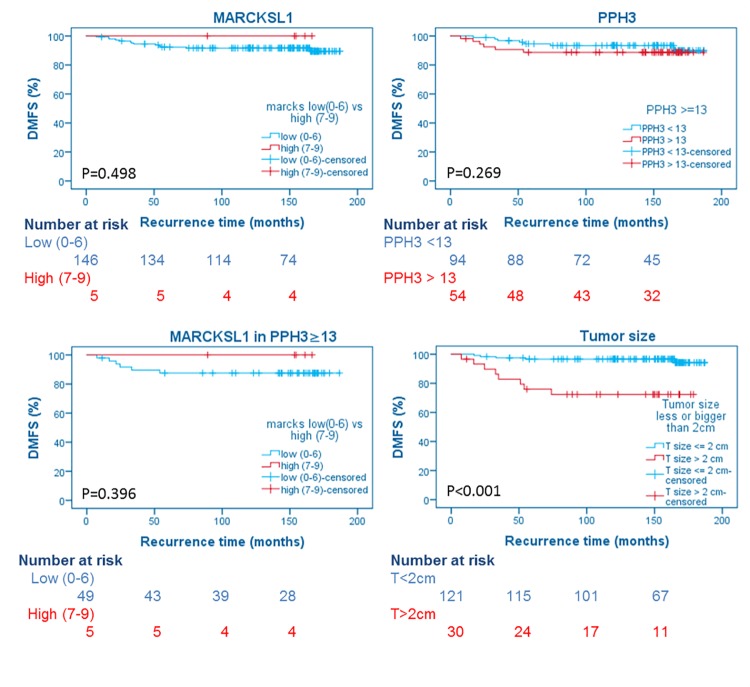
Long-term recurrence-free survival curves according to PPH3 status, MARCKSL1 protein expression score, MARCKSL1 protein expression score in patients with PPH3 ≥ 13, and tumor size.(DMFS, distant metastasis-free survival).